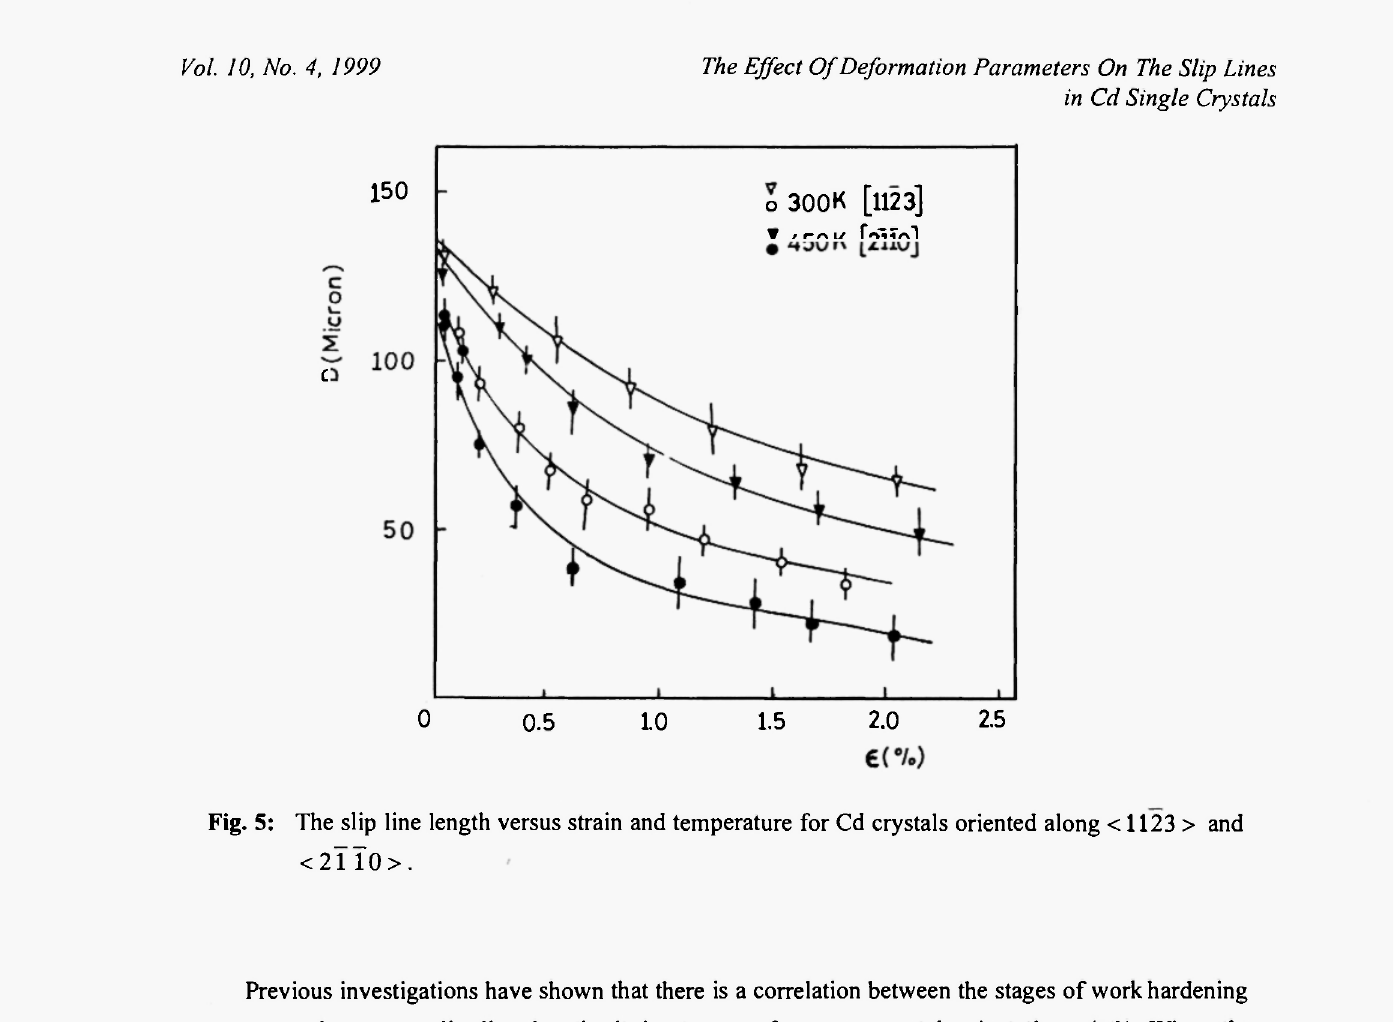
Fig. 5: The slip line length versus strain and temperature for Cd crystals oriented along <1123 > and < 2 l T o